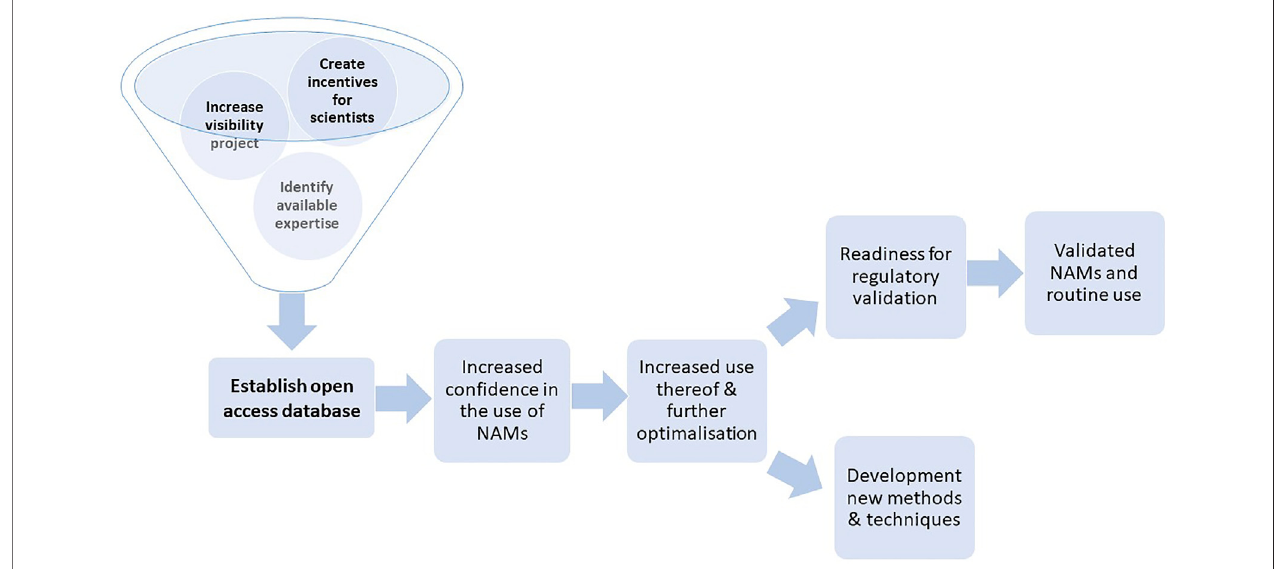
FIGURE 6 | Roadmap to promote the development, use, validation and regulatory uptake of NAMs via the RE-Place project.